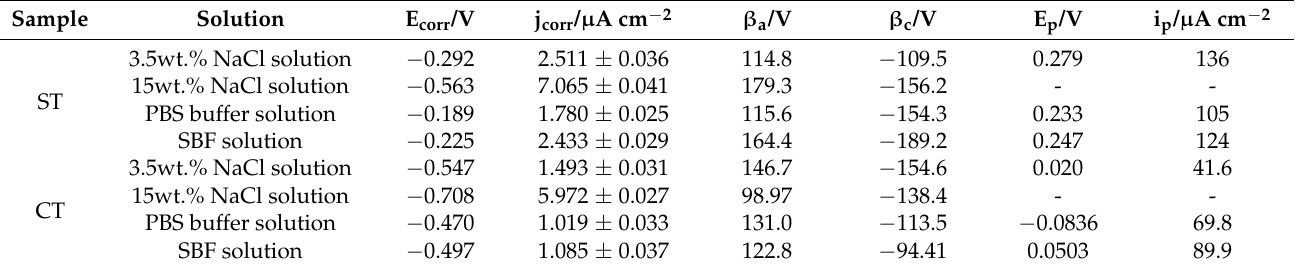
Table 2. Fitting results of potentiodynamic polarization tests for ST and CT in the four solutions.